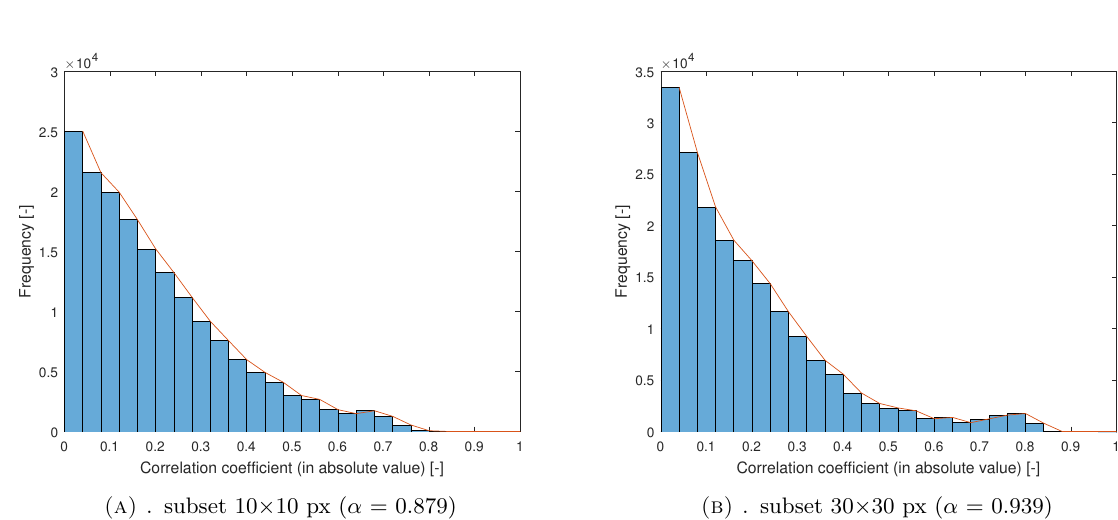
Figure 6. Distribution of correlation coefficient, masonry